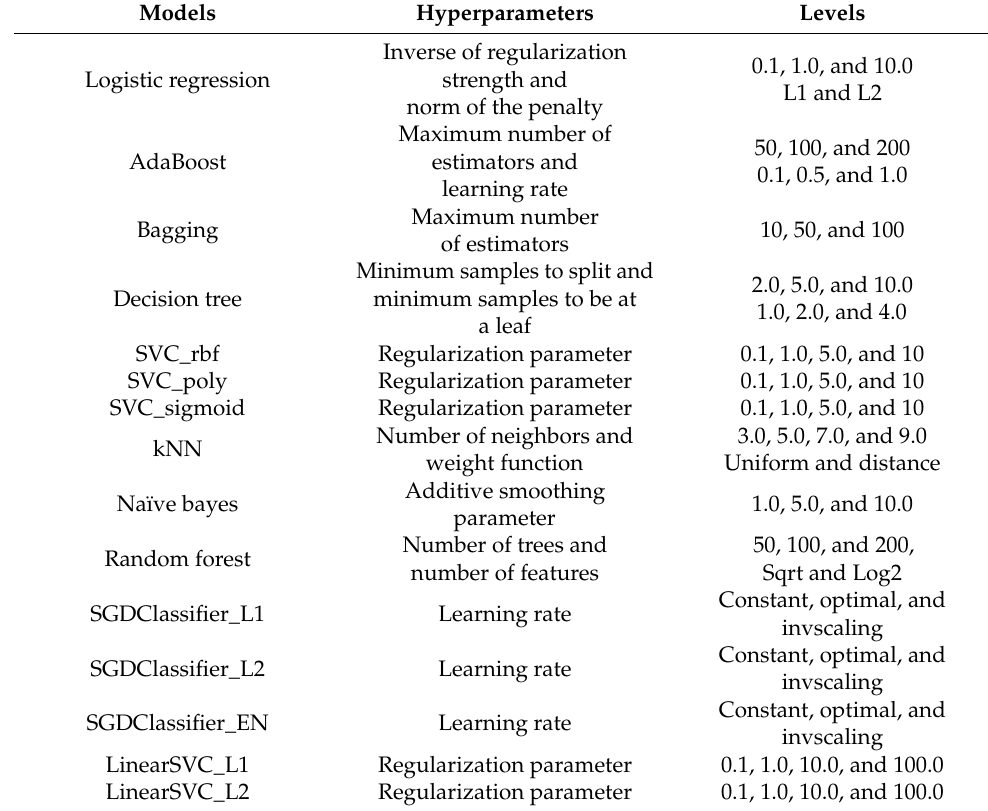
Table 2. Machine learning configurations and hyperparameters tuning